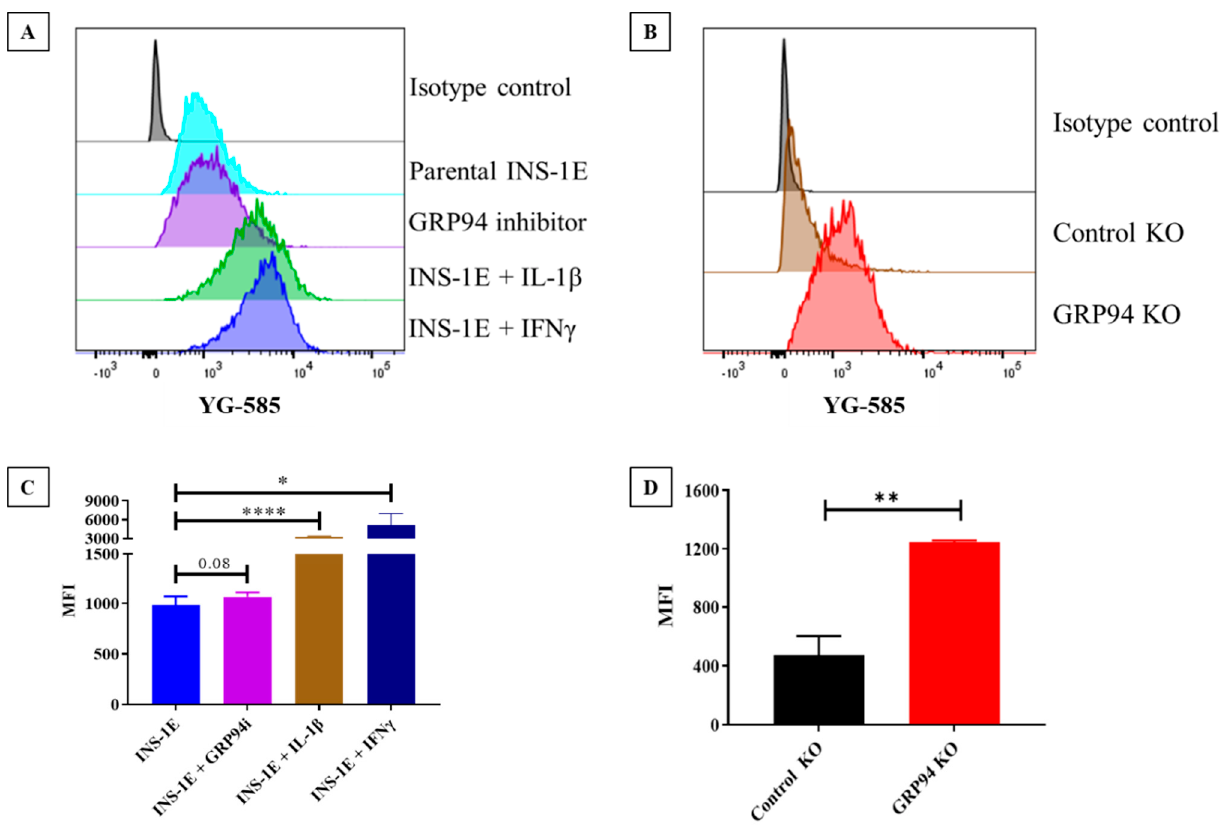
Figure 1. Flow cytometry comparison for RT1.A expression in INS-1E cells under tested conditions. ( A , B ) INS-1E cells compared with relevant controls for RT1.A expression and ( C , D ) statistical comparison for RT1.A expression INS-1E cells in tested conditions versus relevant controls. N = 3 for C and = 6 for D. MFI = mean fluorescence intensity. Drugs/cytokines dose and exposure: GRP94i = 20 µ M, IL-1 β = 15 pg/mL, IFN γ = 10 ng/mL for 24 h. * p ≤ 0.05, ** p ≤ 0.01, **** p ≤